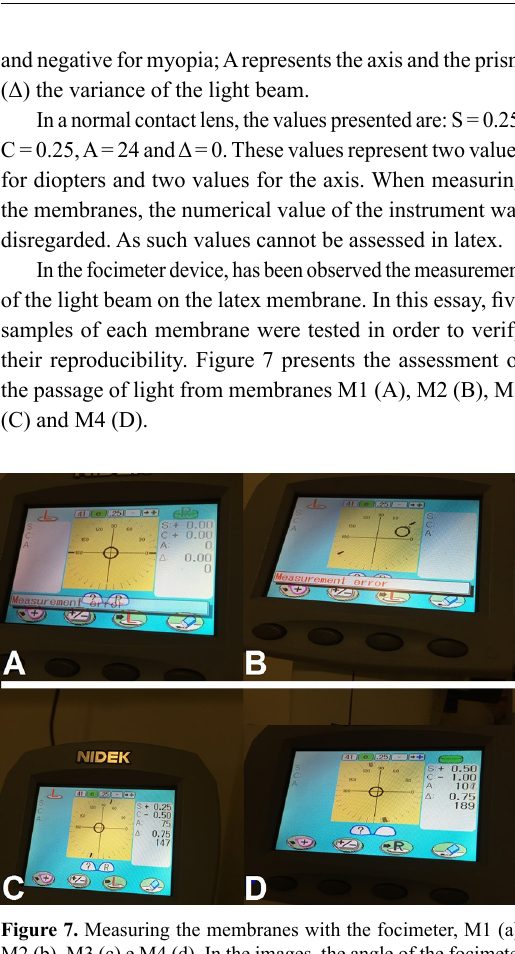
Figure 6. Micrograph of membranes produced by the deposition technique. (a) M3 and (b) M4.